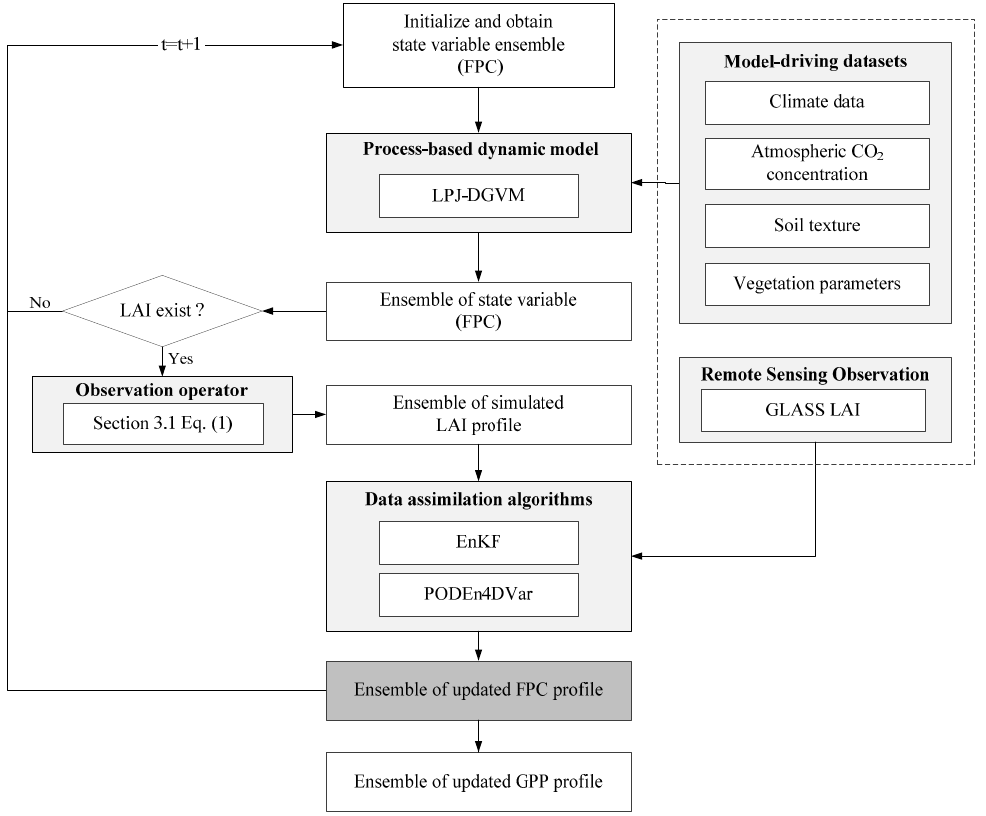
Figure 2. Schematic diagram of the Lund-Potsdam-Jena-data assimilation (LPJ-DA) modeling framework.